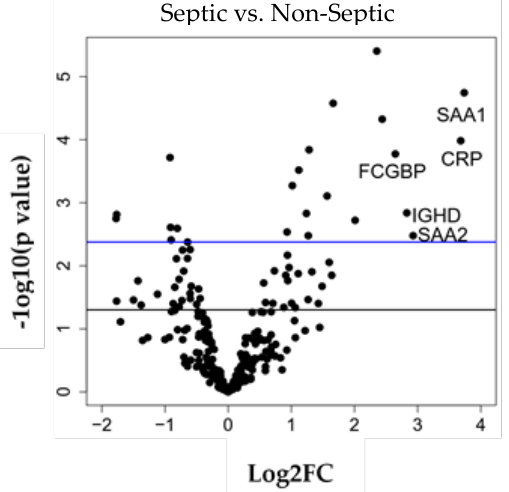
Figure 4. Volcano plot of 26fig1 batch corrected proteins. X-axis: log2 fold change of sepsis versus control; y-axis: −log10 ( p value). Black horizontal line indicates p value = 0.05 and the blue horizontal line indicates FDR = 0.05. Among the 23 significant proteins after false discovery rate (FDR) correction the top five proteins with largest fold changes are labeled in the plot.